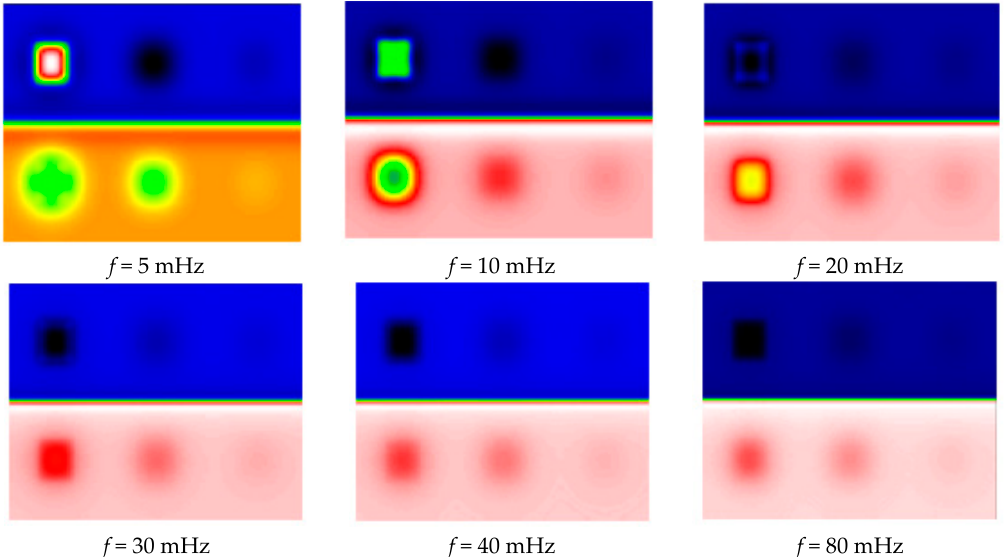
Figure 5. Amplitude images of the calculated harmonic response.